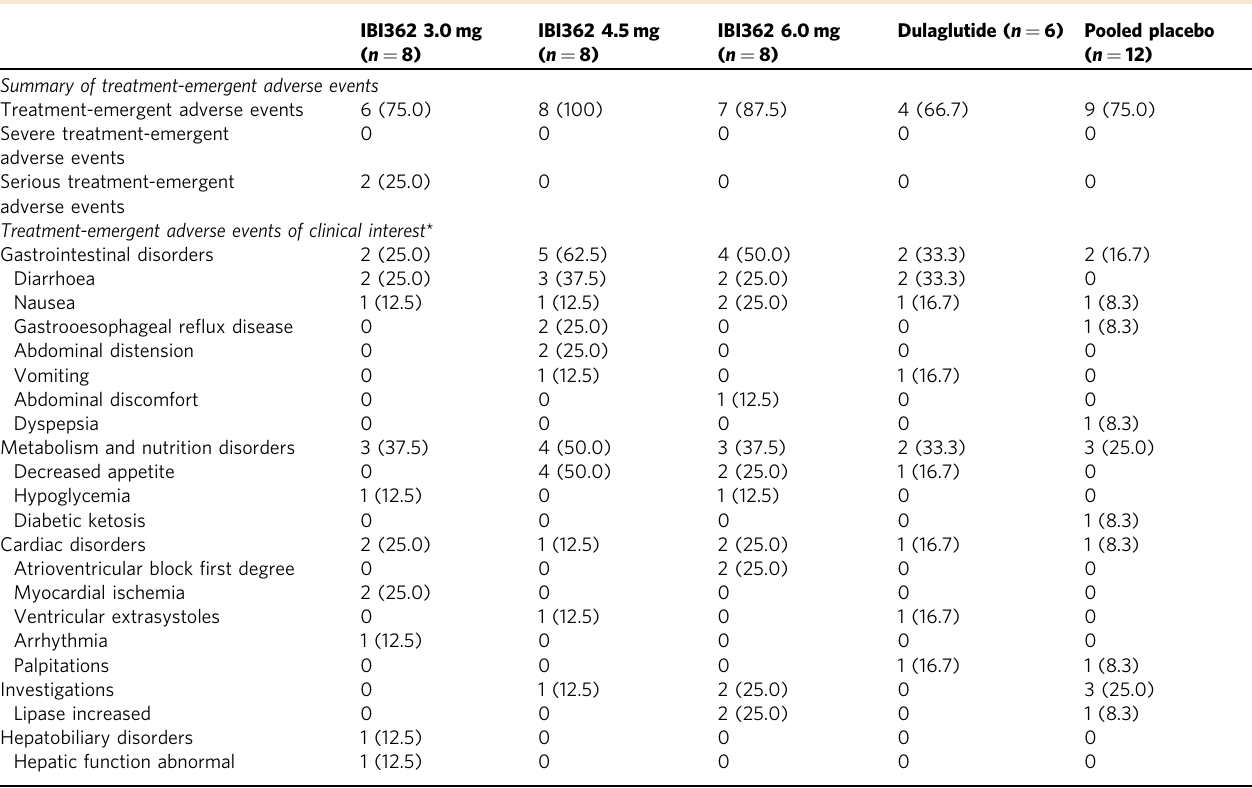
Table 2 Treatment-emergent adverse